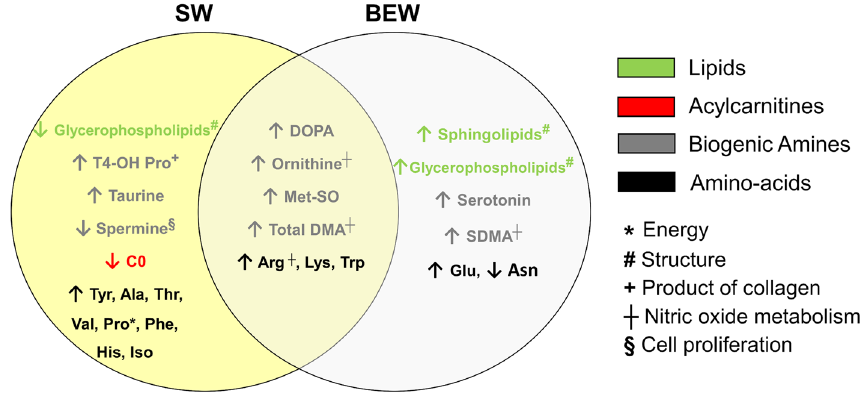
Figure 6. Venn diagram summarizing metabolomic changes in the vitreous of recovering FDEP eyes exposed to SW or BEW light in comparison with control eyes. Significant changes in metabolite levels in FDEP eyes compared to control eyes included increases in biogenic amines and amino acids under both lighting conditions, while glycerophospholipid levels were increased under BEW light and reduced under SW light. Ala alanine, Arg arginine, Asn asparagine, C0 carnitine, DOPA dihydroxyphenylalanine, Glu glutamate, His histidine, Iso isoleucine, Lys lysine, Met-SO methionine sulfoxide, Phe phenylalanine, Pro proline, SDMA symmetric dimethylarginine, Thr threonine, Total DMA total dimethylarginine, Trp tryptophan, Tyr tyrosine, Val